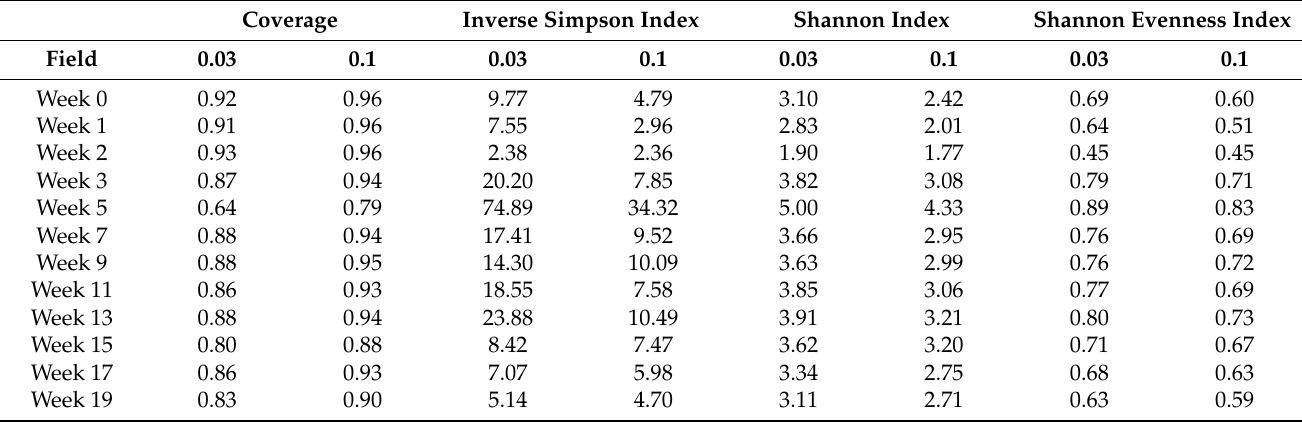
Table 3. The coverage, diversity, and evenness indices at 0.03 and 0.10 genetic distances of bacteria associated with A. diaperinus the weeks after the Spent litter was placed into the pastureland. n = 1 composite sample/Week.